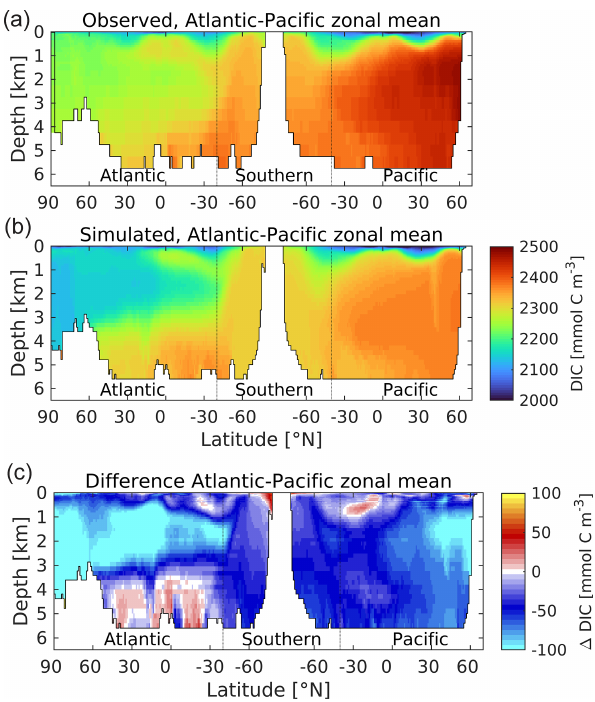
Figure 21. A thermohaline circulation section of observed (a) and modelled (b) zonal average dissolved inorganic carbon. Difference (simulated–observed) is shown in (c) . Concentrations are given in mmolCm − 3 . Figure 6 explains the format of this